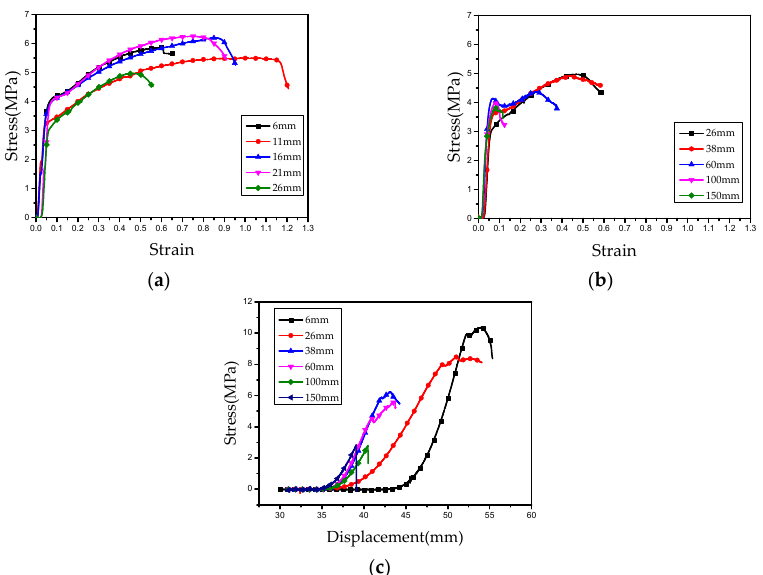
Figure 8. Mechanical property tests for tensile experiment ( a , b ); and for semi-blunt puncture test ( c ).